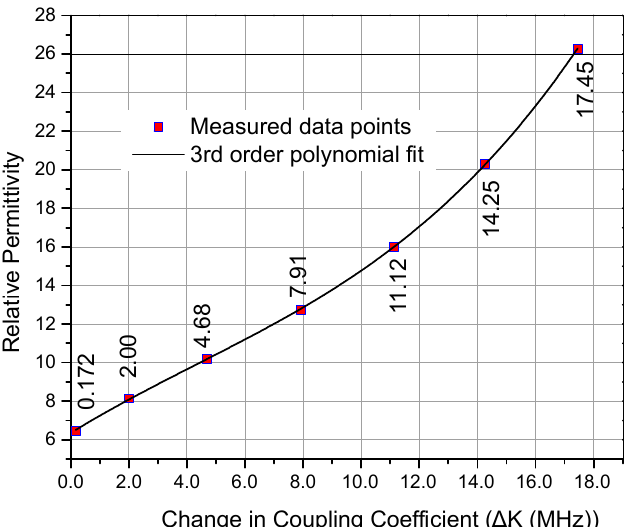
Figure 10. Change in coupling coefficient vs. relative permittivity of the mixture.